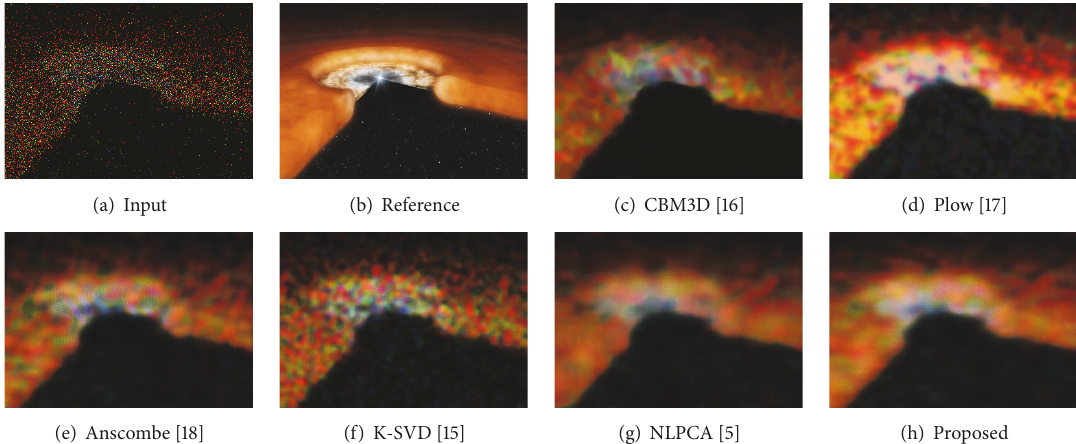
Figure 1: Disk: noisy input, reference, and denoised images (for peak =